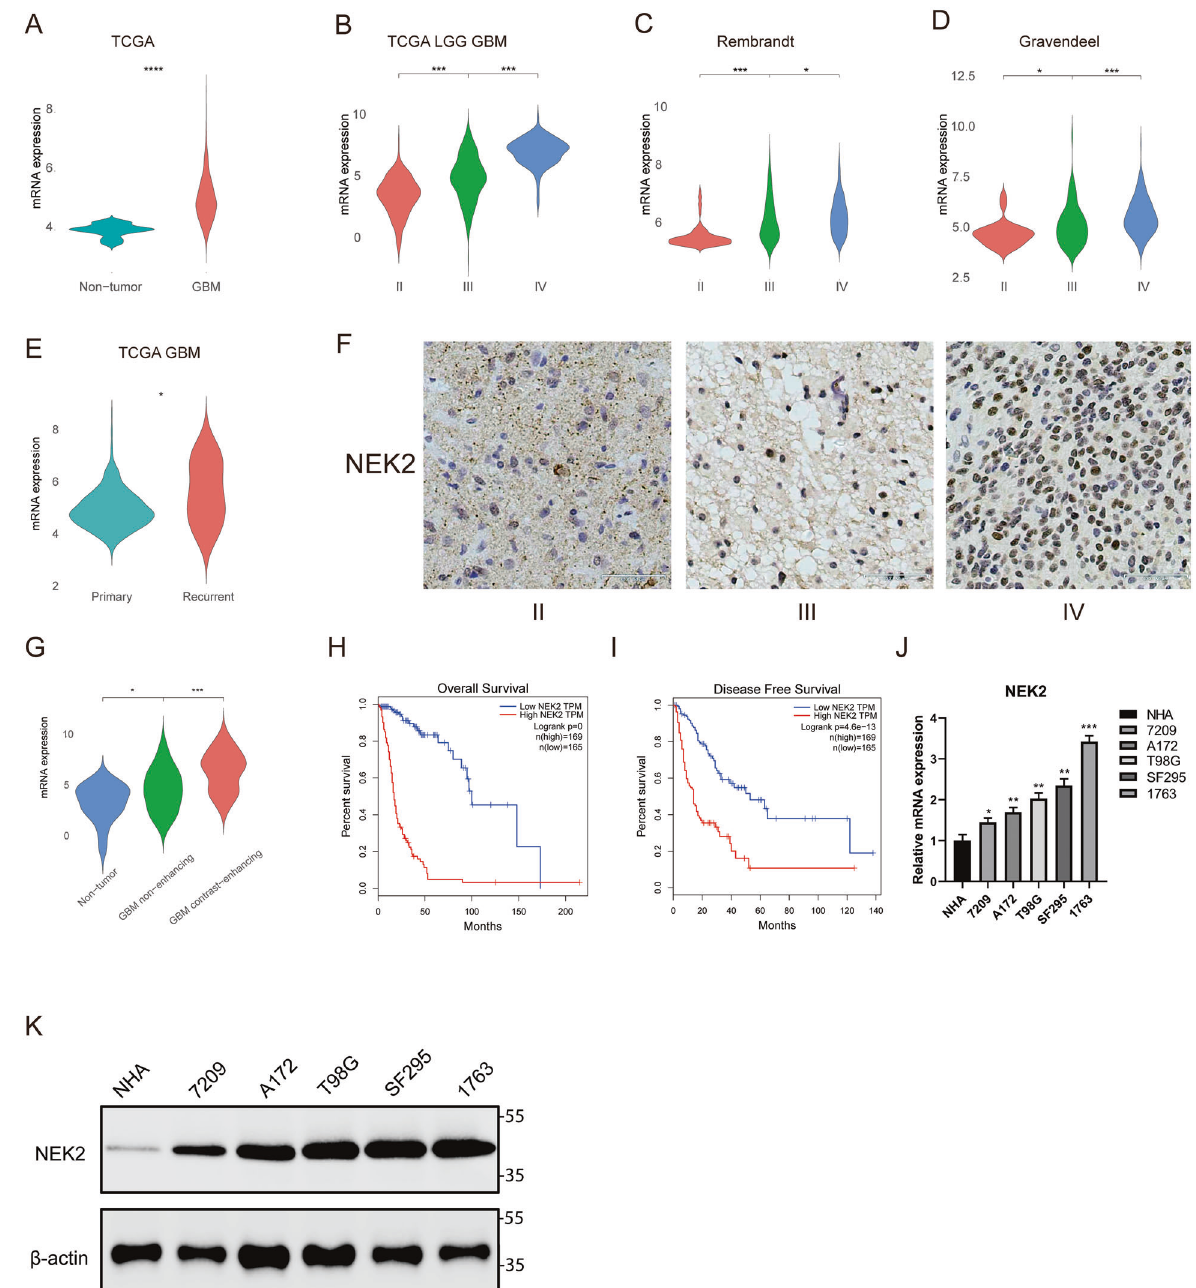
Fig. 1 The expression of NEK2 is signi fi cantly upregulated in GBM patients. A Gene expression analysis in GBM versus nontumor by using TCGA database (* P < 0.001, with student ’ s t -test). B Gene expression analysis with TCGA database in different WHO grades of glioma (* P < 0.001, with student ’ s t -test). C Gene expression analysis with REMBRANDT databases in different WHO grades of glioma (* P < 0.001, with student ’ s t -test). D Gene expression analysis with GRAVENDEEL databases in different WHO grades of glioma (* P < 0.001, with student ’ s t -test). E Gene expression analysis for primary GBM and recurrent GBM by using TCGA database. F Representative IHC images of NEK2 in glioma samples. Brain tissue from epilepsy surgery was used as negative controls. G Gene expression analysis in contrast-enhancing GBM, nonenhancing GBM and nontumor by using GILL25114226 database. H Kaplan-Meier OS analysis for NEK2 expression by using GBM patient samples (* P = 0, with log-rank test). I Kaplan-Meier DFS analysis for NEK2 expression by using GBM patient samples (* P < 0.001, with log-rank test). J NEK2 mRNA expression in human primary glioma cell, commercial human glioma cell lines and NHA by qRT-PCR (** P < 0.01, * P < 0.05, with one-way ANOVA followed by Dunnett ’ s post-test). G Western blot analysis was conducted to detect the protein levels of NEK2 in human primary glioma cell, commercial human GBM cell lines and NHA. β -actin was set as an internal control. All data were reported as the mean ± SD of triplicate independent experiments.